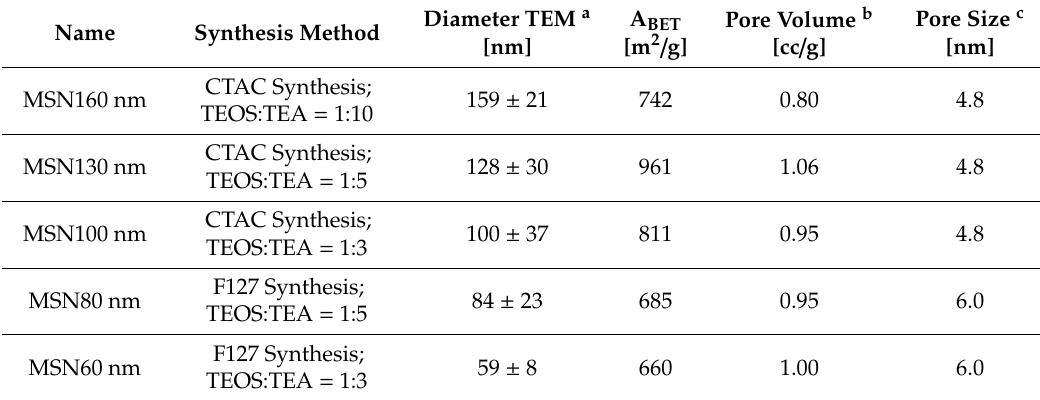
Table 1. Synthesis and properties of MSN